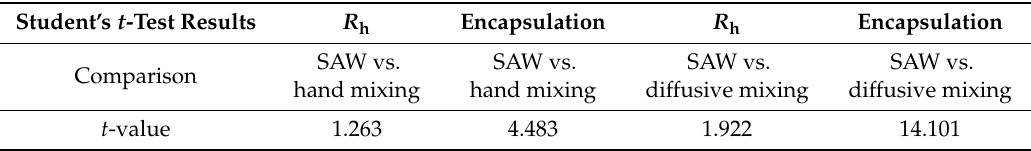
Table 1. Student’s t -test results for data in Figure 9 (critical value of Student’s t -test for significance